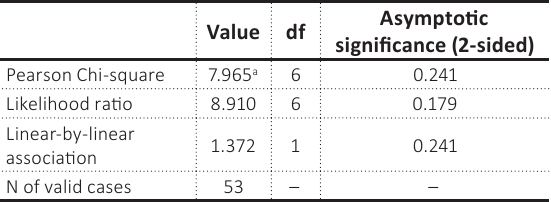
Table 2. Chi-square tests between general